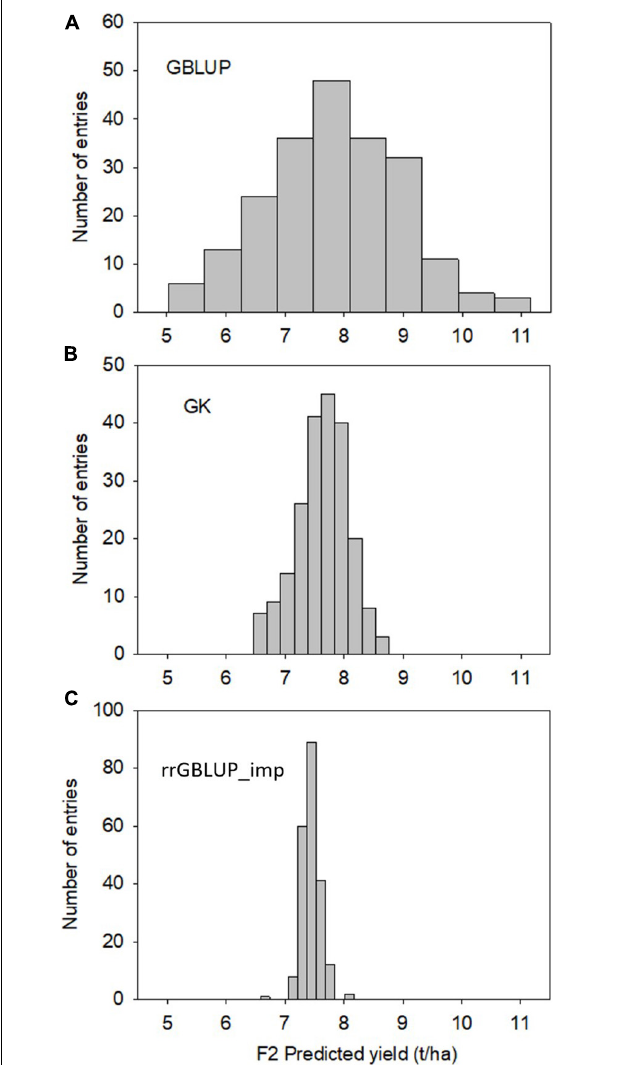
FIGURE 3 | Experiment 1. Box-plots comparing grain yield distribution of all the lines for Genomic Bi-parental (Gen-BP), Conventional Bi-parental (Con-BP), and Rapid Cycle Intercross population (RCI) populations (blue box-plots) and their corresponding top 10% entries (red box-plots).